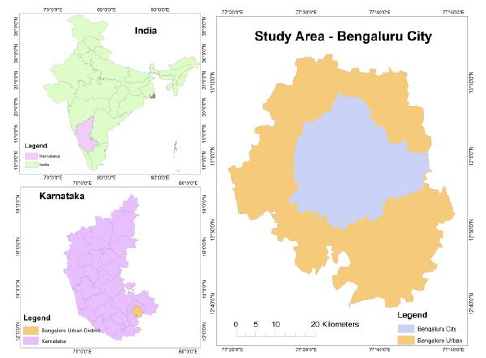
Figure 1: Study area map of Bengaluru